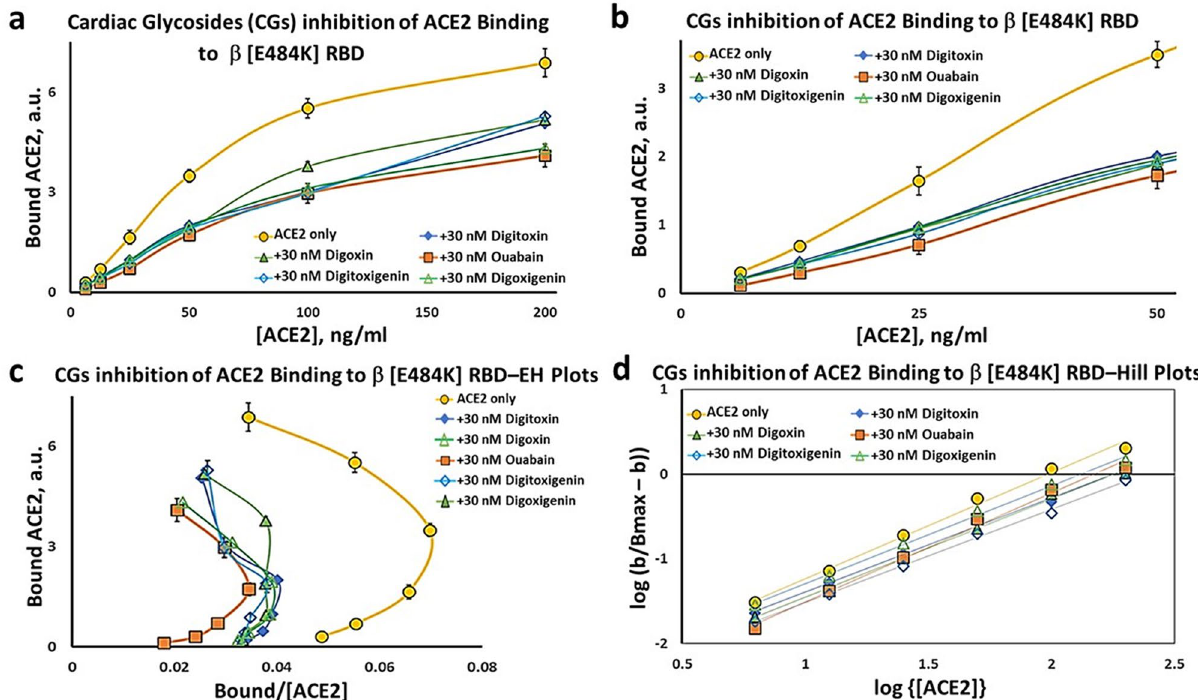
Figure 7. Inhibition of ACE2 binding to β [E484K] RBD by cardiac glycosides. ( a ) Substrate-binding plots for inhibition of ACE2 binding to β [E484K] RBD by digitoxin, digoxin, ouabain, digitoxigenin and digoxigenin (30 nM). ( b ) Substrate-Binding plots of data from Part ( a ) at low concentrations of ACE2. ( c ) Eadie–Hoffstee plots of data in Part ( a ). ( d ) Hill plots for each titration from Part ( a ). Magnitude and error for Hill coefficient (n H ) given in Supplemental Fig. 5 Each point is the average ± SE for N = 5–6 independent their sugar-free derivatives have inhibitory activity, although the most active drug is ouabain. Finally, the B max values for these drugs are similar while the slopes of the linear portion of the EH plots at high ACE2 concentra- tion are systematically higher than the control. Thus the inhibitory mechanisms appear classically competitive. Figure 7d shows the Hill plots for all five cardiac glycoside drugs and sugar-free derivatives. Equivalent results for the Mink [Y453F] RBD protein and the α/β/γ [N501Y] RBD protein are shown in Supplementary Figs. S6 and S7 respectively. The calculated K i values for these drugs and their sugar-free derivatives are shown in Table 2. Ouabain has the lowest K i value of the three cardiac glycoside drugs. Digoxigenin has a slightly lower K i value for Mink [Y453F] and α/β/γ [N501Y]. Thus relative cardiac glycoside potency for inhibition of ACE2:RBD binding appears to depend both on the drug structure, and on the mutation. The Hill plot slopes, n H , from Fig. 7d and Supplemental Figs. S6d and S7d vary between ~ 1.1 and ~ 1.3 for all tested variant Spike proteins, and are summarized in Supplementary Fig. S5a. The highest values are for β [E484K], regardless of which drug or drug-derivative is present in the analysis. To determine the significance of these observed differences we calculated p-values for the difference between the observed n H value for each condition and n H = 1.0, where cooperativity is zero (Supplemental Fig. S5b). The mutant with the highest sig- nificance, independent of the treatment, is the β [E484K]. The drug that most significantly affects the most mutants is ouabain. Operationally, a high value of n H is associated with a more lengthy lag in ACE2 binding at low concentrations of ACE2. Cardiac glycosides block penetration of Spike‑pseudotyped VSV virus into lung cells. To test whether cardiac glycosides blocked the viral penetration process we tested drug effects on cell entry by luciferase ( luc )-loaded Spike-pseudotyped VSV(S) viral particles. To further focus the experiment on the earliest entry steps we also used a triple tandem time-of-addition method. Briefly, VSV(S) particles were first preincu- bated for 1 h with cardiac glycoside drugs in DMEM at 37 °C. Secondly , the particles and drugs were then prein- cubated with the A549 cells in DMEM for 2 h at 37 °C. Thirdly , the viral particles and drugs were washed away and replaced by complete DMEM medium. The A549 cells were then incubated for 24 h at 37 °C before assay for luciferase. Figure 8a shows the results of luminescence background-corrected activity of luc -loaded pseudotyped VSV(S) over the active ranges for digitoxin, digoxin and ouabain. Ouabain was found to potently suppress viral entry. Digitoxin was less potent and digoxin was the least potent. Based on these data the Hill plot-based EC-50 value for ouabain was calculated to be 16 ± 1 nM (N = 3, ± SE). The positive and negative control values are given in Supplemental Table S1. The inhibition data are similar when measured either by ratio to the luminescence control (Fig. 8b), or by % of positive control (Fig. 8c). As a negative control, and to test for whether human ACE2 receptor was required for cell penetration, mouse 3T3 cells were substituted for human A549 cells. Mouse 3T3